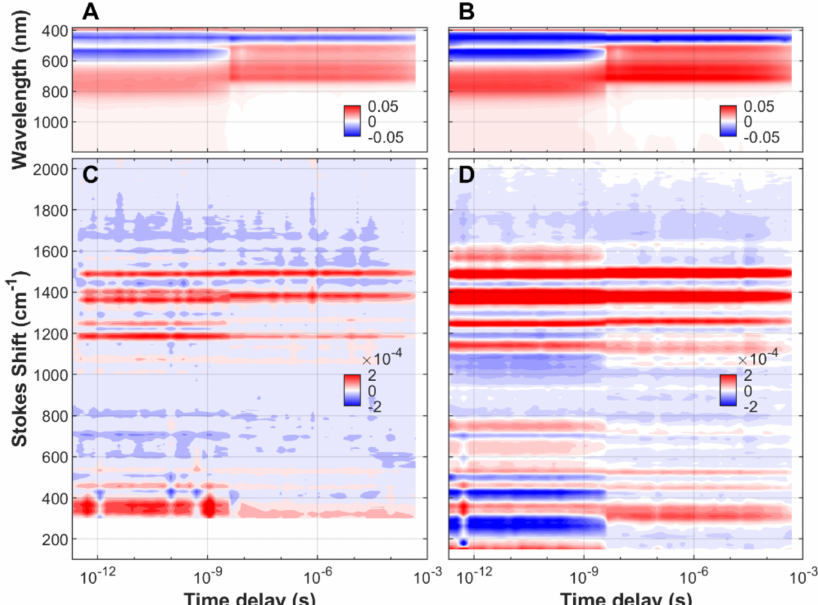
Figure 3. Time-resolved sub-picosecond to sub-millisecond Raman/absorption of FMN bound to EL222-C78A upon excitation with a 475 nm actinic pump. ( A ) TA spectroscopy in H 2 O-based buffer. ( B ) TA spectroscopy in D 2 O-based buffer. ( C ) Transient FSRS in H 2 O-based buffer. ( D ) Transient FSRS in D 2 O-based buffer. Other parameters are as in Figure